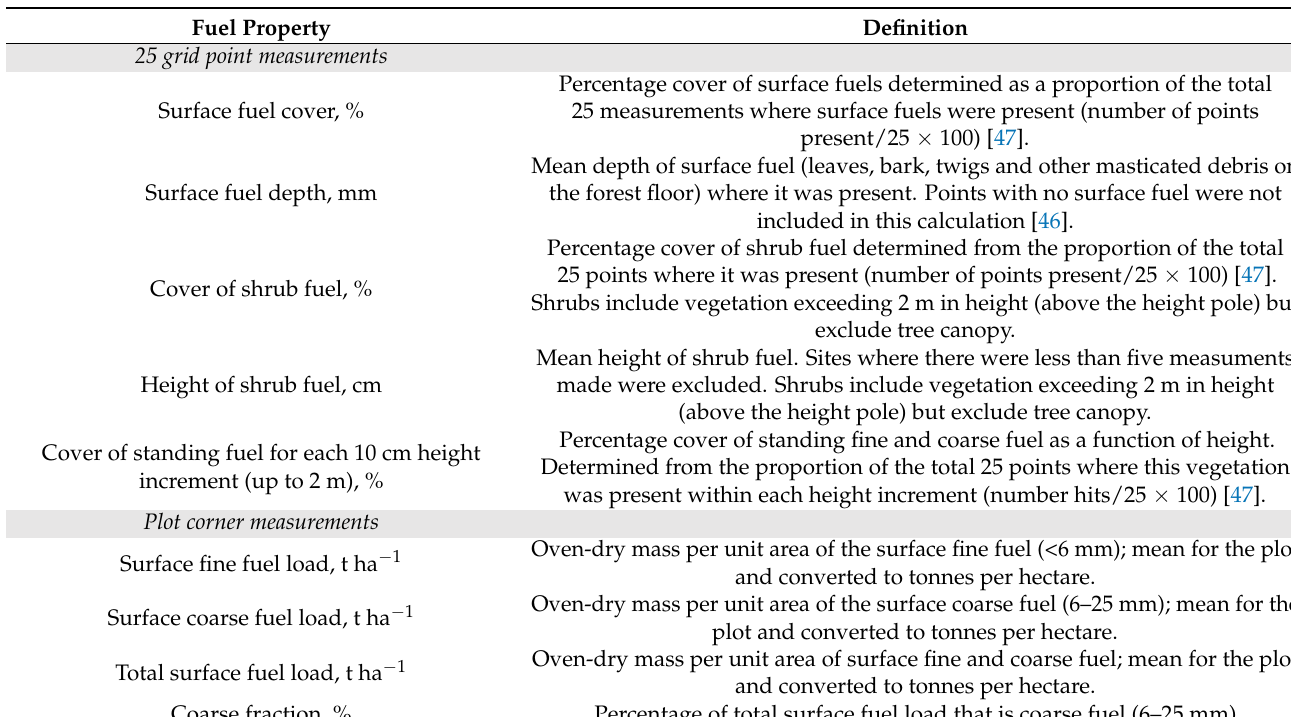
Table 1. Summary of the fuel property measurements taken in the